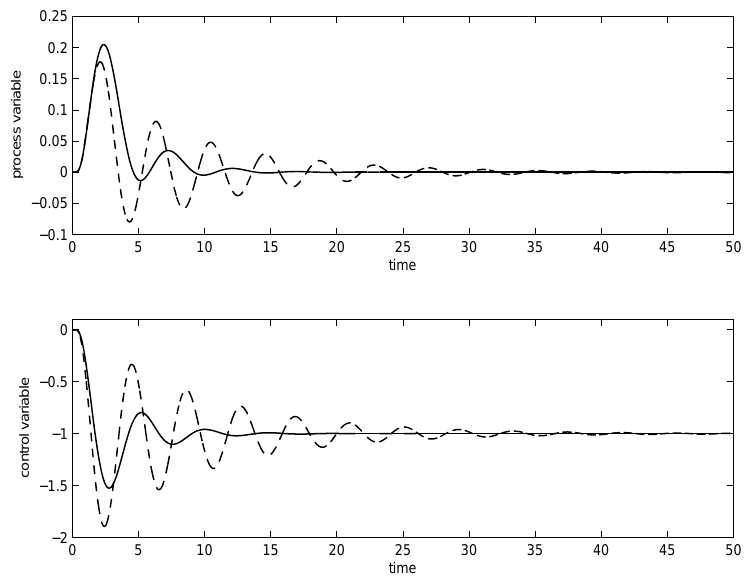
Figure 12. Load disturbance step response for PI control for a distributed lag process. Dashed line: initial tuning; solid line: after